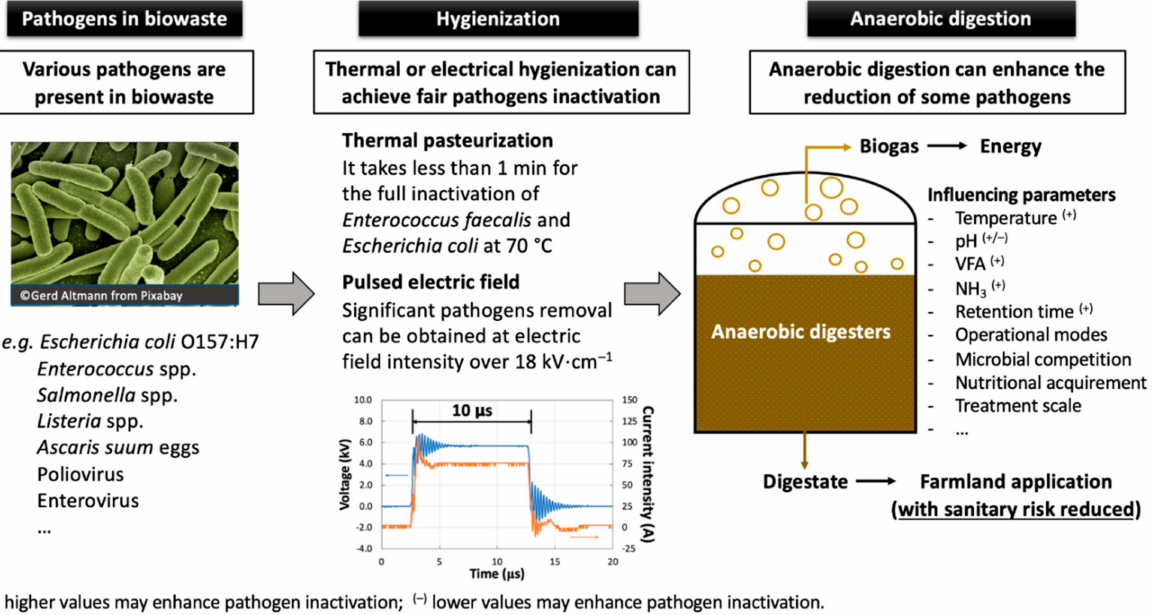
Figure 5. Descriptive diagram of various AD parameters serving for sanitary